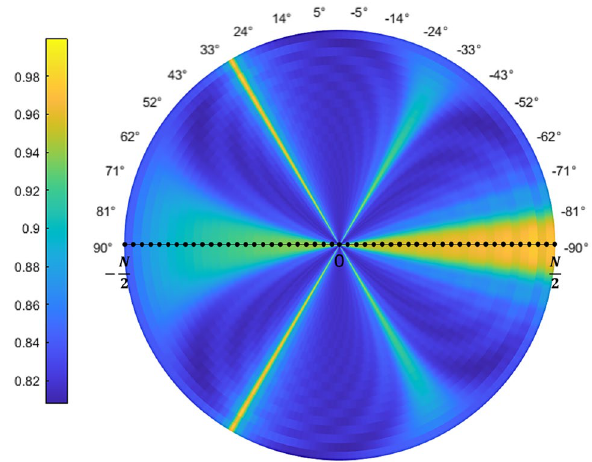
Figure 3. Polar color map of the normalized value for the intensity on each particle as the array rotates from − 90 to 90 for a wavelength of 750 nm. Note how the field is increased at the end fire configuration ( θ = ± π/ 2 ) and at the resonant angle given approximately by ± 30 °.